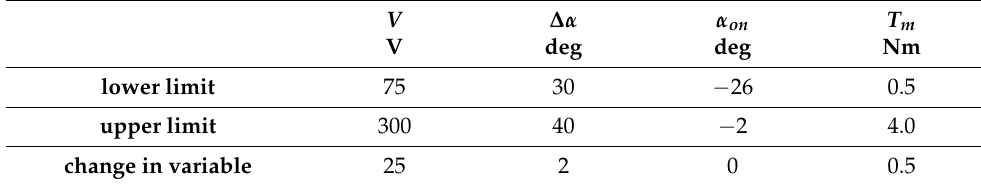
Table 1. Ranges of control parameter values and their changes.